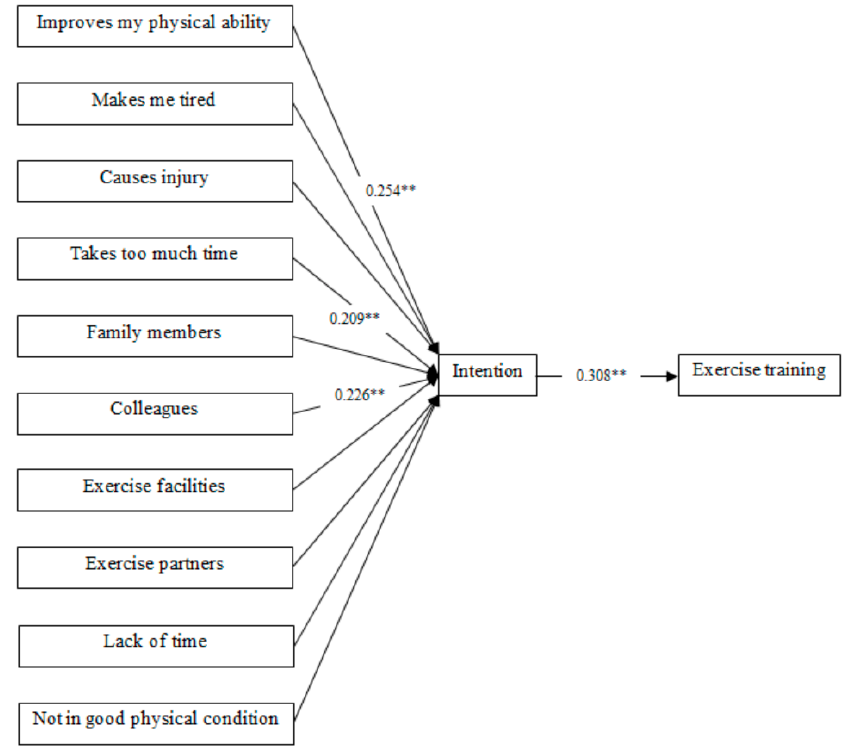
Figure 2. Structural equation modeling ( N = 171).